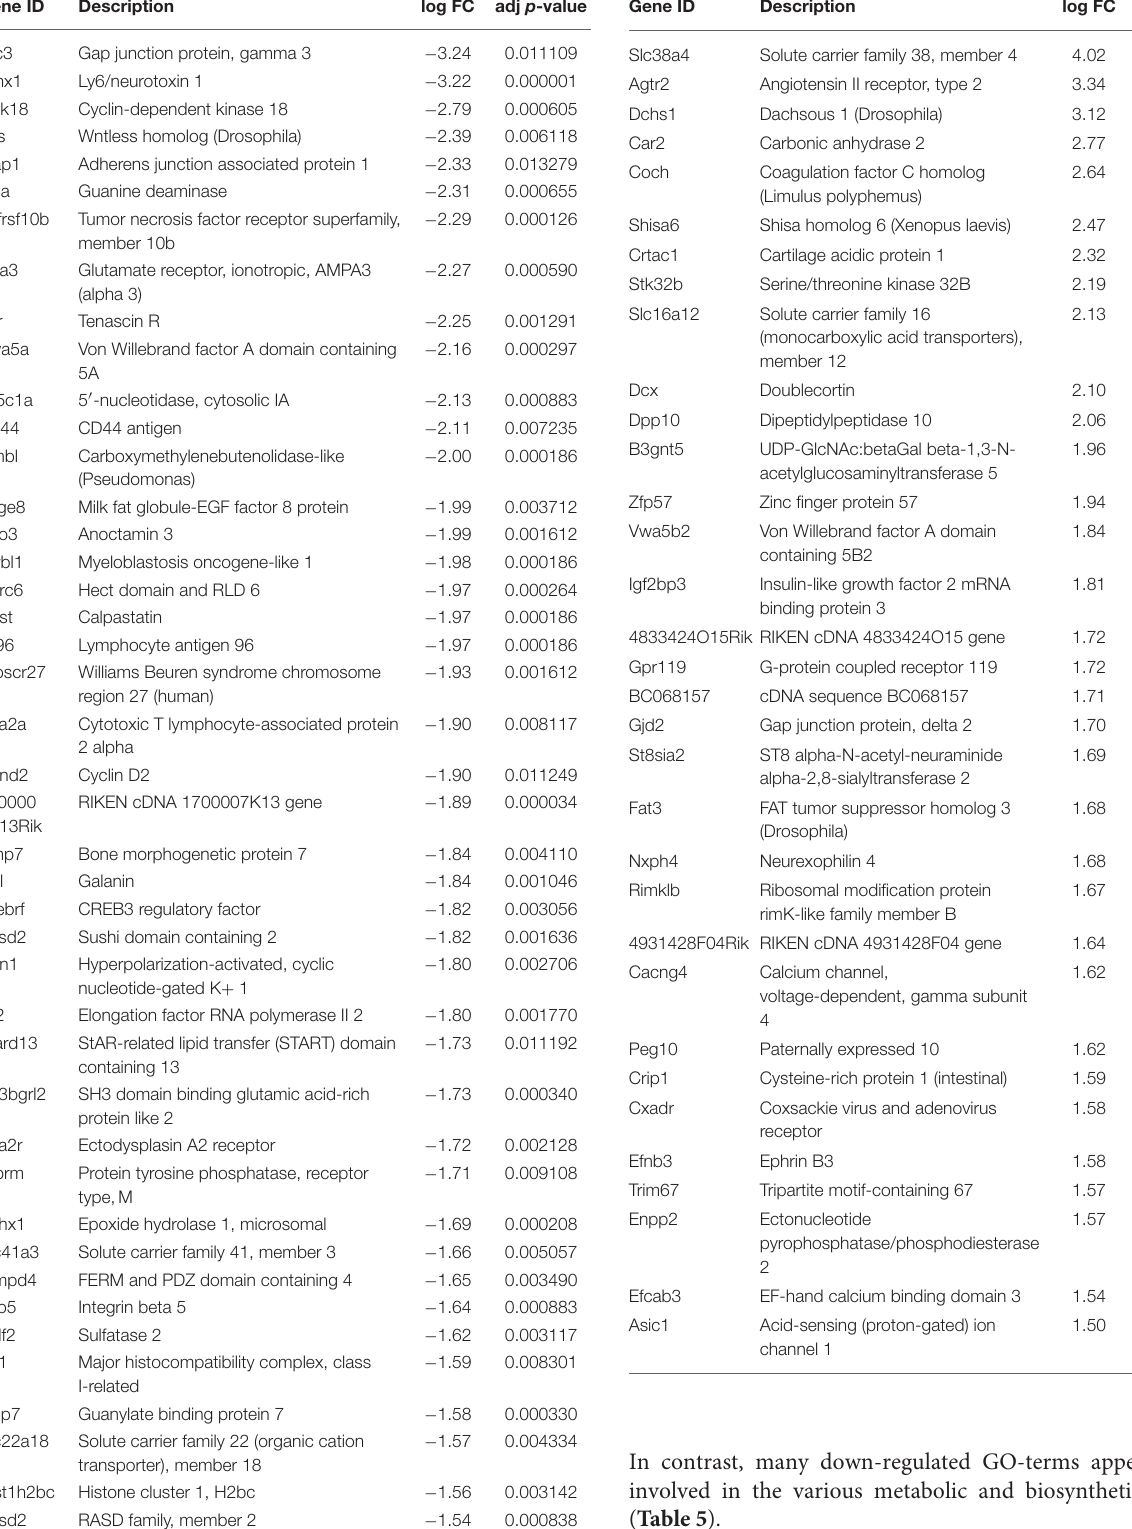
TABLE 2 | Most significantly up-regulated genes in the 21DIV compared to 5DIV SCG neurons (adjusted p < 0.01 , log fold change > 1.5).